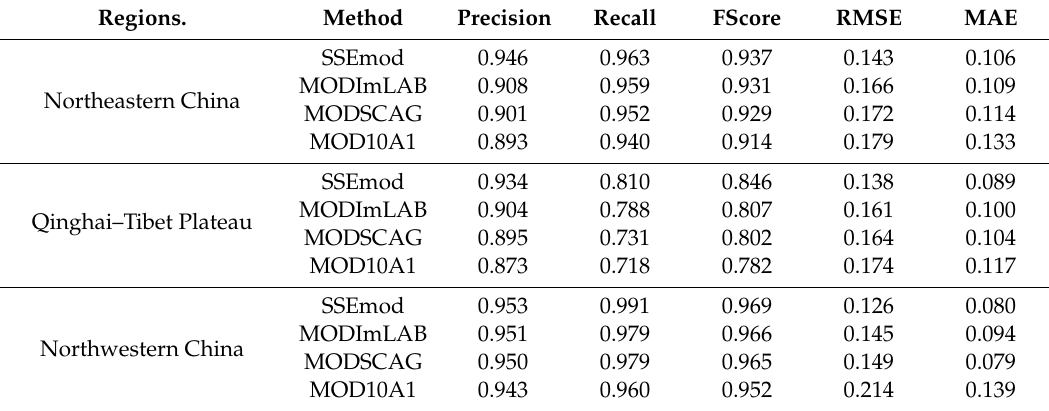
Table 1. The average accuracy validation results of di ff erent metrics of di ff erent methods for FSC retrieval in three snow-covered regions of